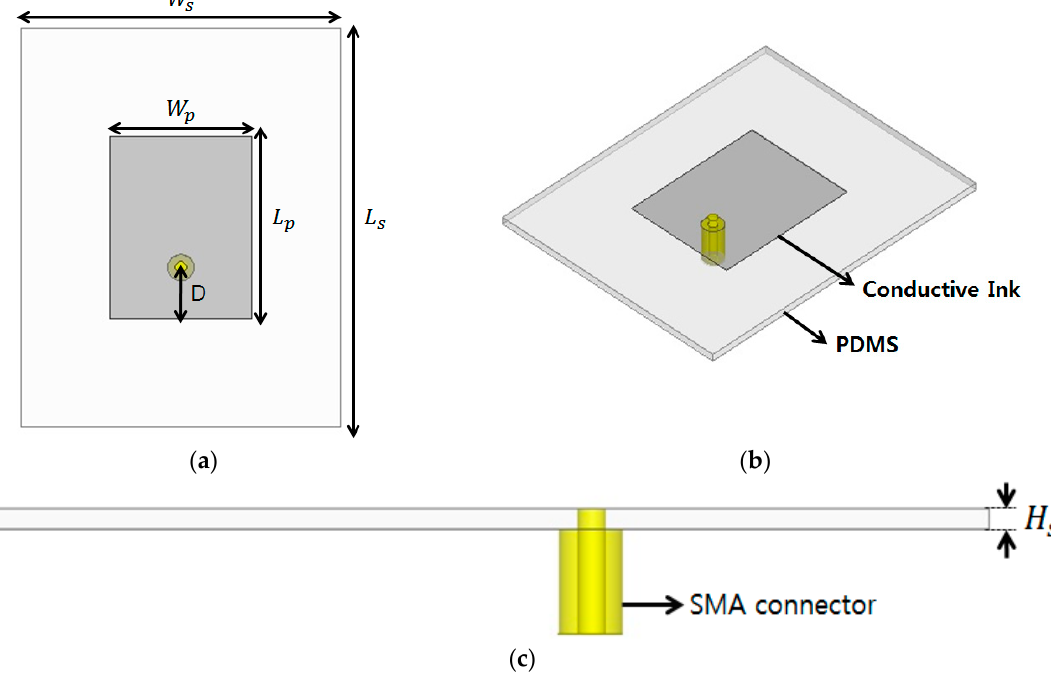
Figure 1. Geometry of the proposed radio-frequency (RF) strain sensor: ( a ) top view, ( b ) perspective view, and ( c ) side view. W p = 17 mm, L p = 23 mm, W s = 40 mm, L s = 50 mm, D = 6.5 mm, and H s = 1 mm.